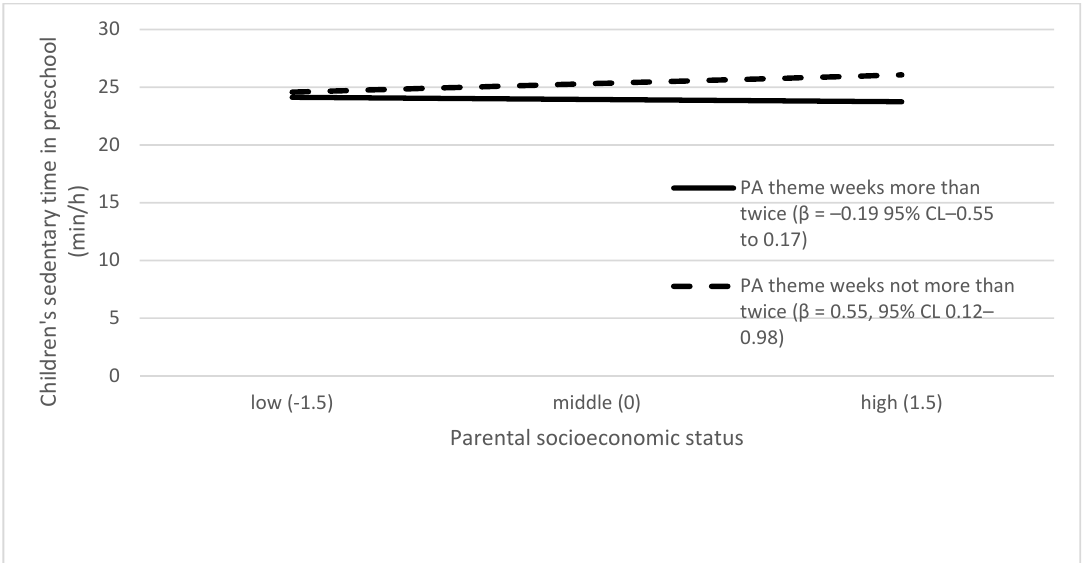
Figure 3. Interaction between PA theme weeks and parental socioeconomic status in predicting children’s preschool sedentary time. Lines in the graphs in Figure 3 represent the dichotomized values there have been physical activity (PA) theme weeks more than twice (solid line) and PA theme weeks not more than twice (dashed line).